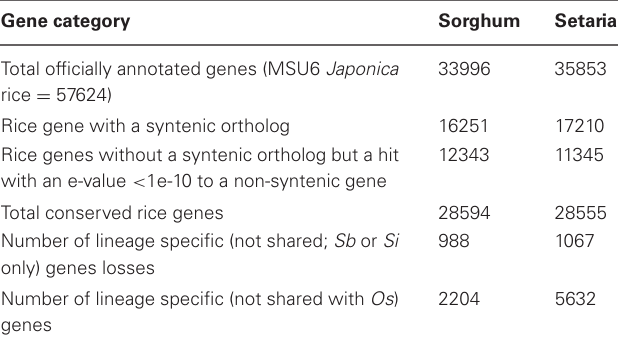
Table 1 | Gene conservation in Os-Sb and Os-Si.